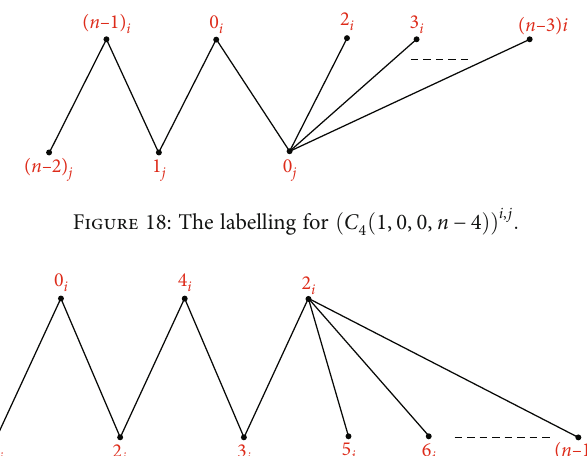
1, 0, 0, 0, n − 5 ÞÞ i , j : 5 ð